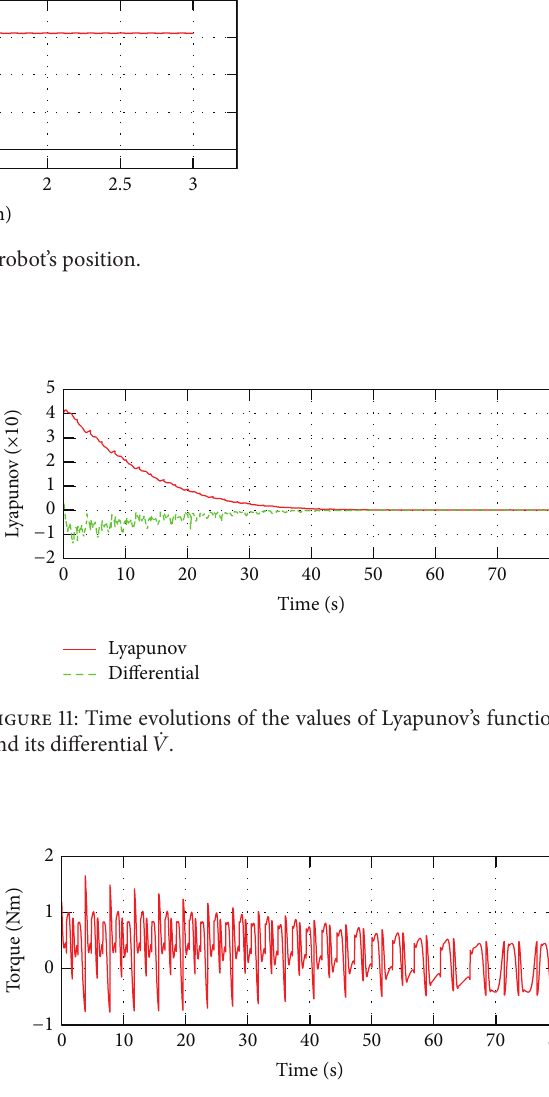
Figure 12: Time evolution of the input torque 𝑢